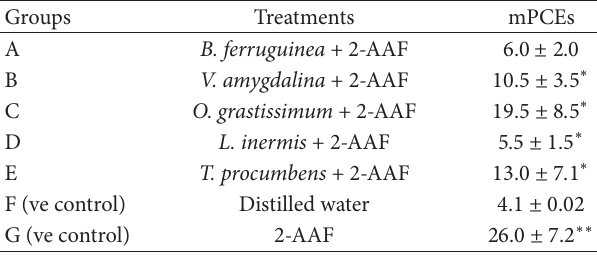
Table 1: mPCEs count in rats treated with the plant extracts and 2-AAF.